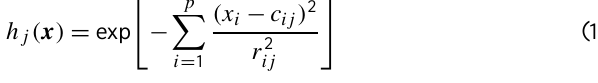
FIG. 2: KMLB gauge network.